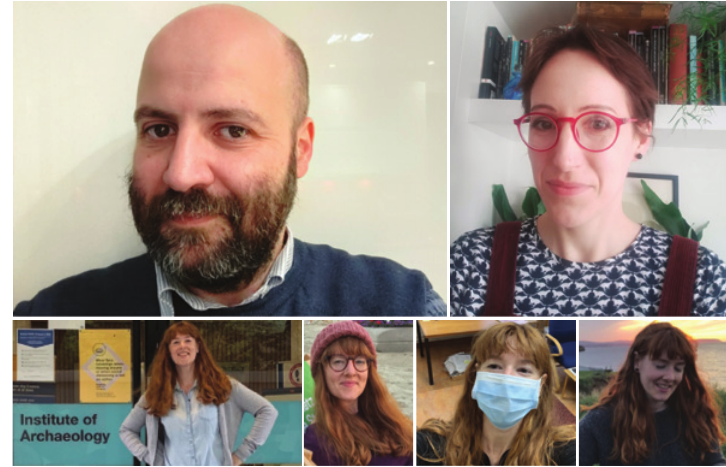
Figure 5 (Top left) Borja Legarra Herrero; (top right) Jill Saunders; (bottom) Rebecca Watts (Sources: photographs by Borja Legarra Herrero, Jill Saunders and Manoela Dantas